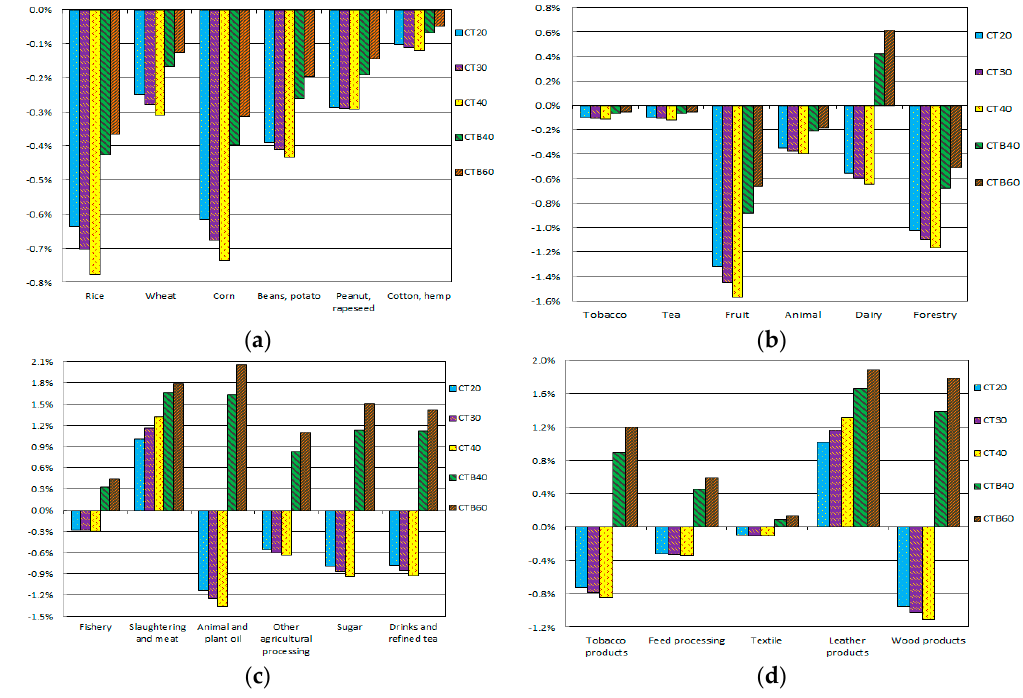
Figure 5. The changes in the outputs in agriculture-related sectors under different scenarios (compared with the BAU scenario). Table 10. The changes in outputs in agriculture-related sectors under different scenarios compared with the BAU scenario (%) (from sugar to wood products).